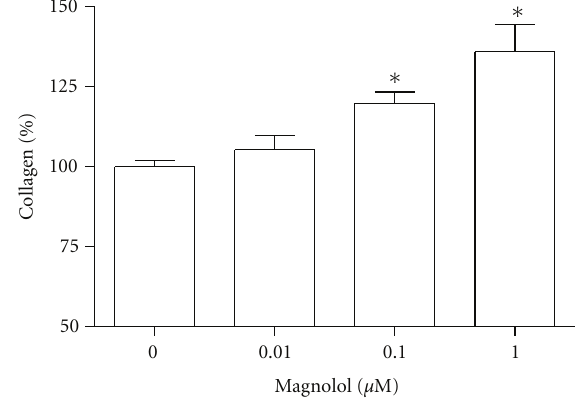
Figure 3: E ff ect of magnolol on the alkaline phosphatase activity of MC3T3-E1 cells. Data were expressed as a percentage of control. The control value for ALP activity was 0.871 ± 0.016 Unit/mg. ∗ P < 0 . 05 compared with control.